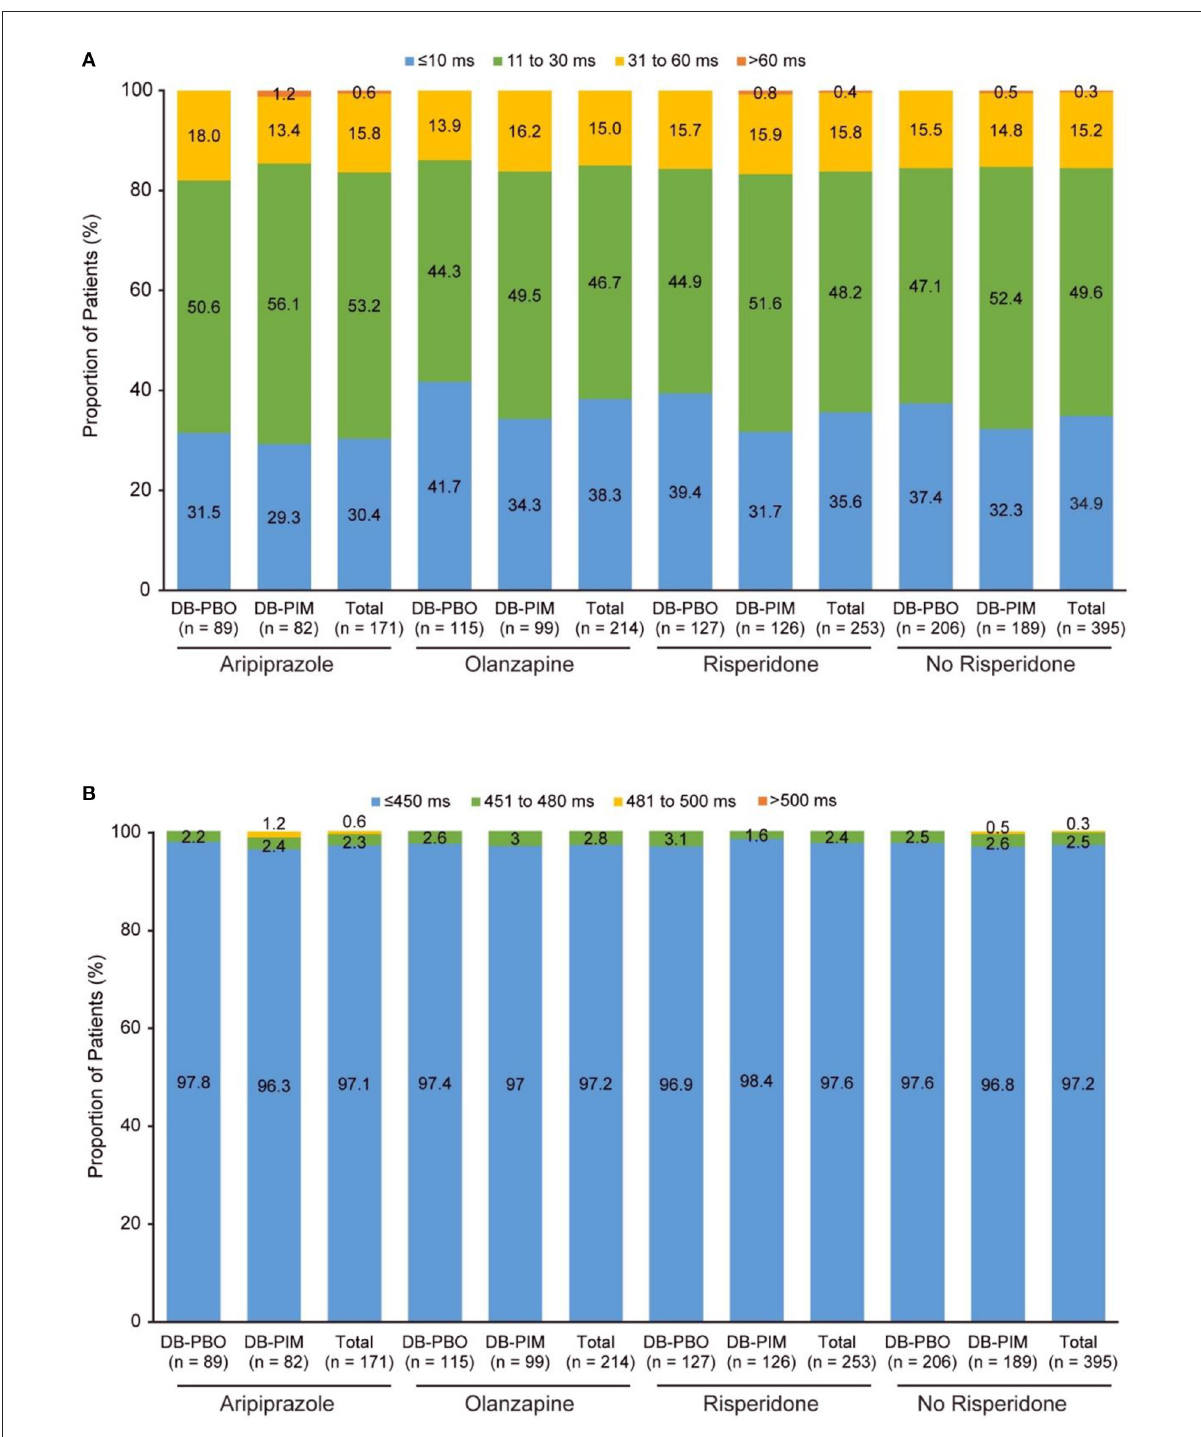
FIGURE3 Study 035 a : (A) Change in QTcF from double-blind baseline to overall postbaseline maximum and (B) QTcF overall postbaseline maximum. a After the double-blind studies (ENHANCE and ADVANCE), patients could enroll in study 035, an extension study. Patients are grouped by their randomized treatment (placebo or pimavanserin) from the ENHANCE and ADVANCE trial, but all patients were treated with pimavanserin throughout the 52-week extension study. DB, double-blind; PBO, placebo; PIM, pimavanserin; QTcF, QT interval using Fridericia’s correction